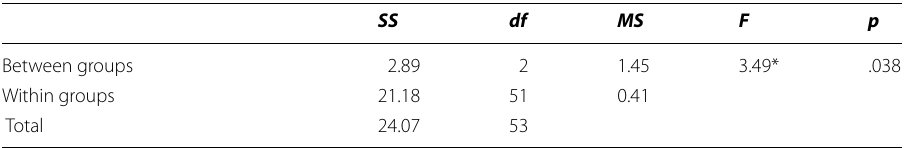
Table 5 Results of the ANOVA